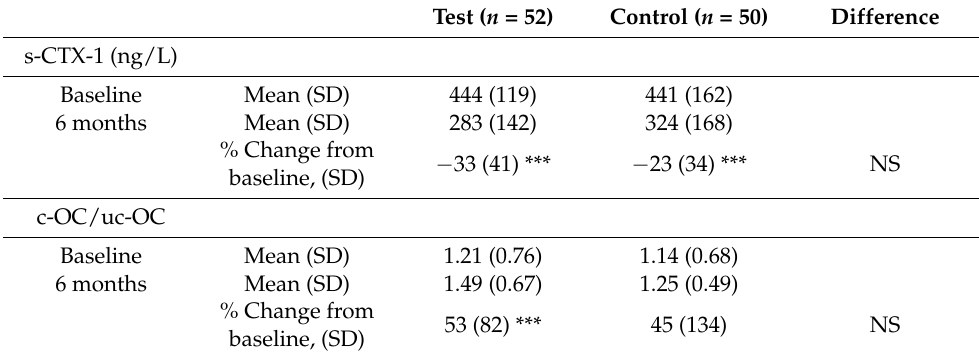
Table 3. Changes in biochemistry in response to test and control products over six